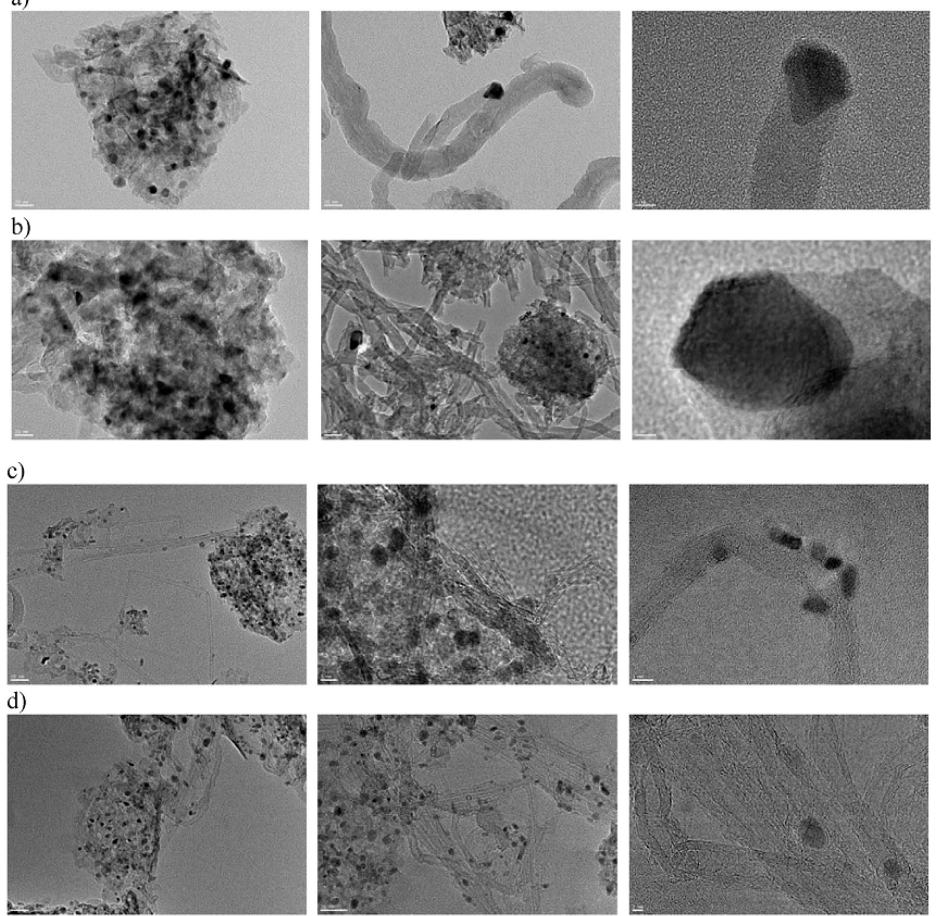
Figure 2. TEM images for ( a ) HT-25Ni; ( b ) HTNi-Ce; ( c ) HTNi-Zr; and ( d ) HTNi-CeZr catalysts after 300 min methane dry reforming (DRM) at 550 °C (reprinted with permission from Ref. [54], copyright 2016 Elsevier).